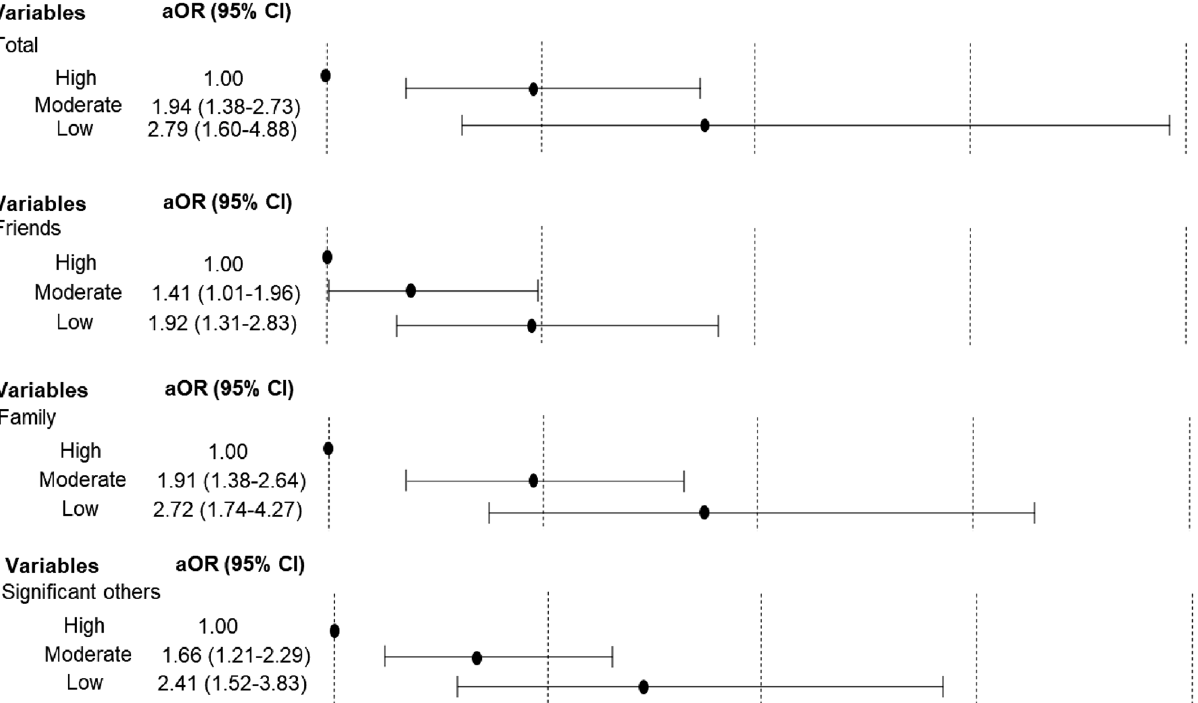
Figure 1. The results of subgroup analysis based on postpartum depression according to social support by social support